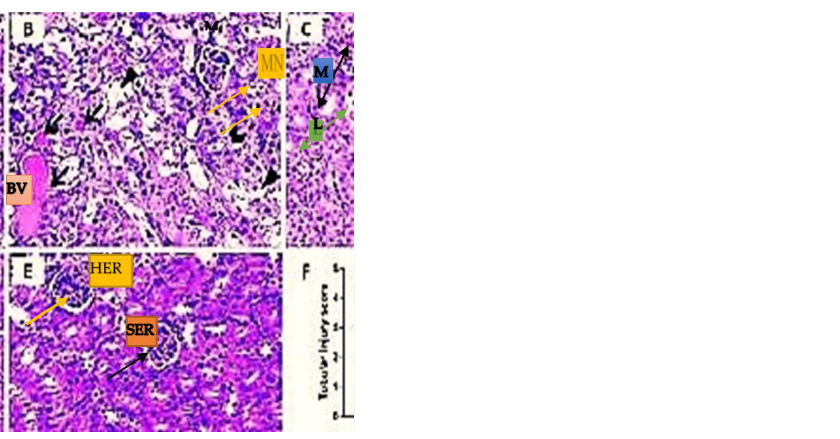
Figure 4. Photomicrographs of damaged blood cells ( A ) = 0.80 mg/L Nittol showing monocytes M, ( B ) = 1.00 mg/L Nittol showing: blood vessels BV and Lymphocytes L and micro nucleus MN, ( C ) = 1.20 mg/L Nittol showing monocytes and lymphocytes M,L, ( D ) = 1.40 mg/L Nittol showing monocytes and lymphocytes M,L, ( E ) = 1.60 mg/L Nittol haemolysed erytheocytes HER and swollen erythrocytes SER, (F)= The titular injury score of the blood cells.